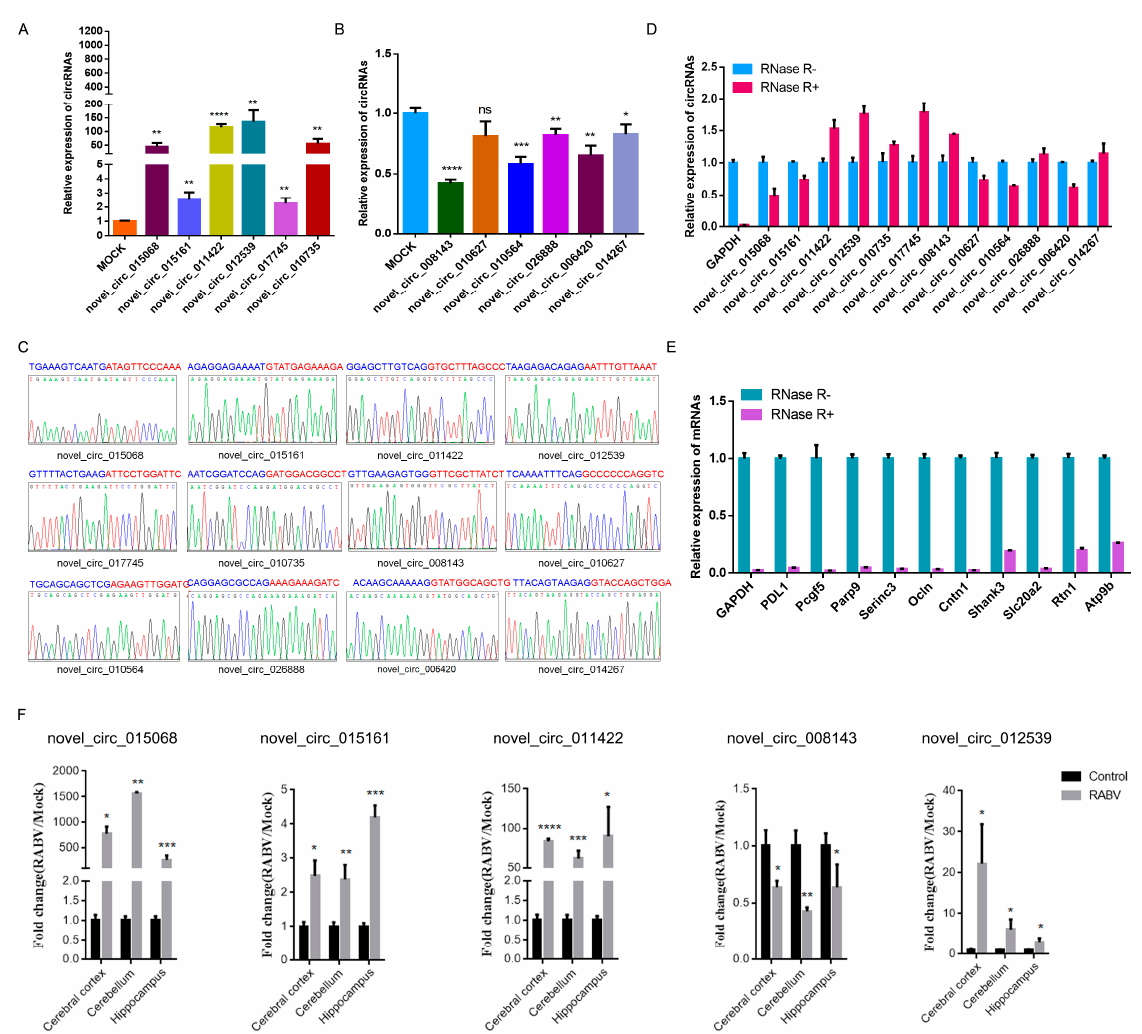
Figure 3. Validation of circRNAs. Expression changes of six upregulated ( A ) and six downregulated ( B ) circRNAs in RNA sequencing data were tested with divergent primers by RT-PCR; ( C ) Validation of back-splice junction sequences by Sanger sequencing; RNase-R resistance assay of 12 selected circRNAs ( D ) and corresponding linear transcripts ( E ); ( F ) Expression level of 5 circRNAs in the cerebral cortex, cerebellum, and hippocampus with or without RABV infection ( p < 0.05, *; p < 0.01, **; p < 0.0005, ***; p < 0.0001, ****).